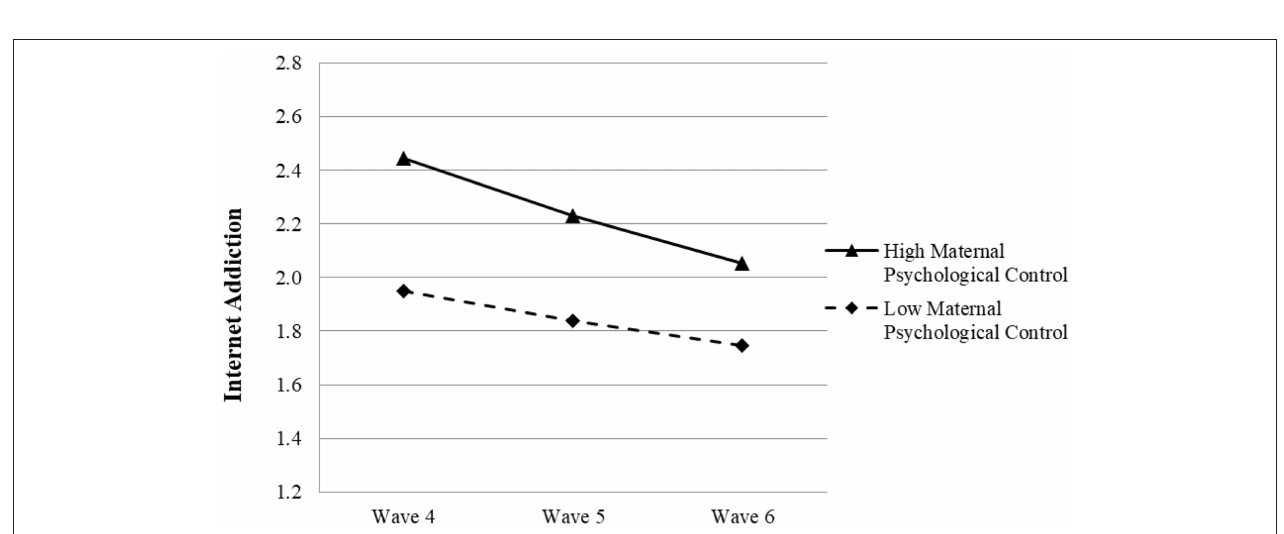
FIGURE 3 | Growth trajectories of adolescent Internet addiction as a function of maternal psychological control. The figures were plotted based on Model 4b shown in Table 6 . High level indicates 1SD higher than the mean value; low level indicates 1SD lower than the mean value.